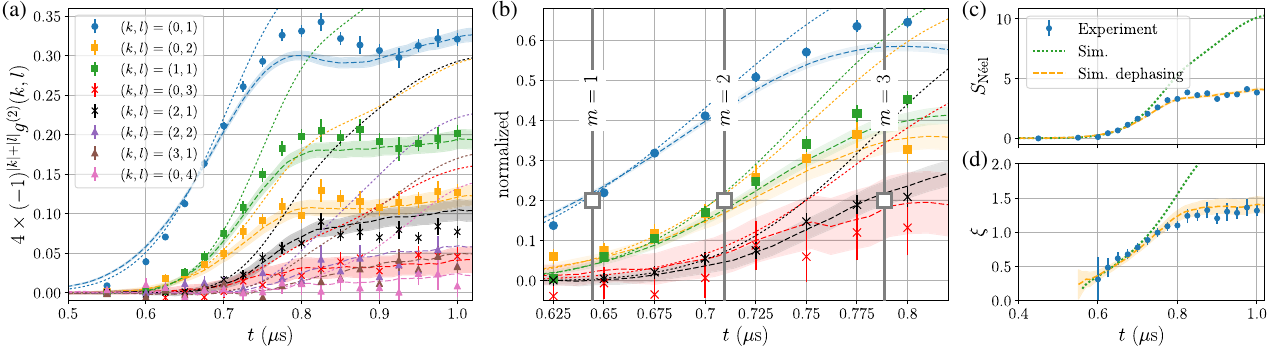
1 . 0 μ s. (a) Buildup of correlations along the ramp. FIG. 4. Time evolution of a 6 × 6 square array along a ramp with t tot ¼ (b) Observation of a time delay between the buildup of significant correlations in increasing Manhattan shells m . This is the manifestation of a finite propagation speed of correlations in their buildup between distant sites (see text). (c) N´eel structure factor and (d) correlation length ξ . All figures: The dotted (dashed) lines correspond to the result of a numerical simulation for a 4 × 4 lattice without (with)